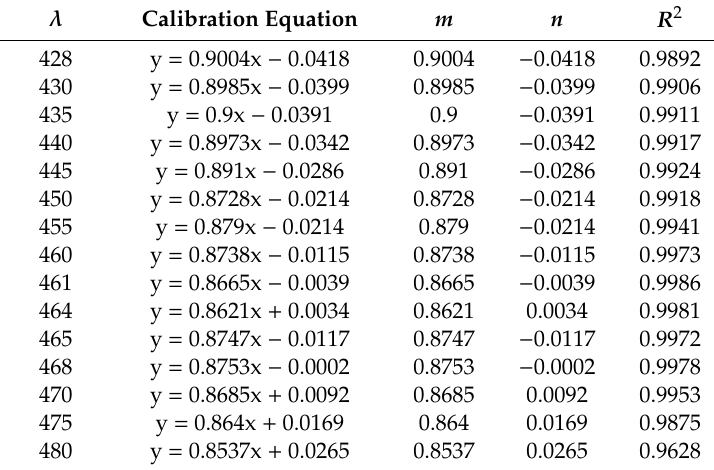
Table 3. Calibration straight lines between 427 and 480 nm (Blue).